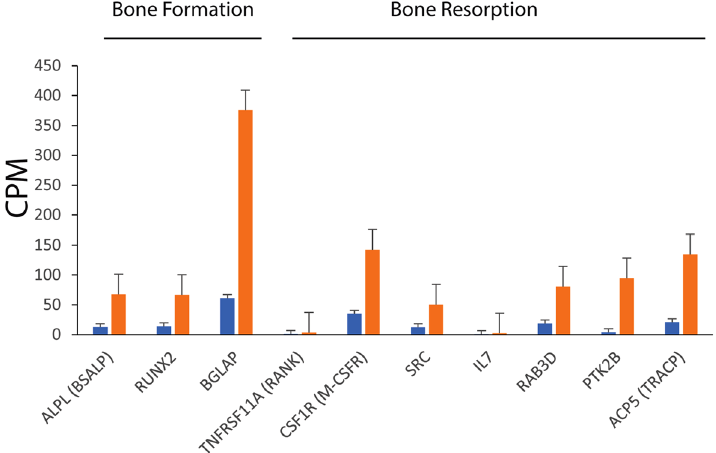
Figure 1. Normalized expression values of selected differentially expressed genes involved in bone homeostasis in hibernating (blue bars) and summer active (red bars) bears. CPM—the mean read count per million RNA- seq reads and its standard